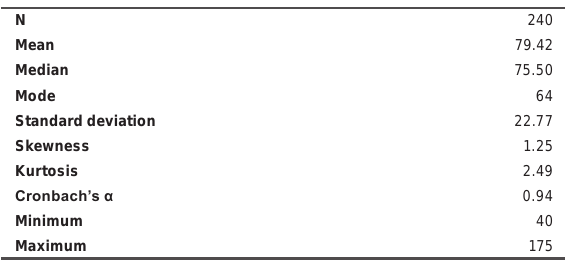
TABLE 4 Descriptive statistics for stress levels as measured by the Experience of Work and Life Circumstances